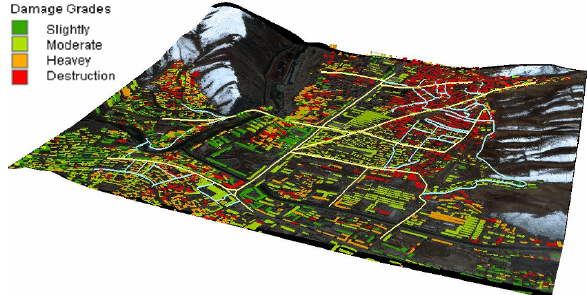
Figure 12: The distribution of seismic damaged buildings in Gyêgu town in Yushu